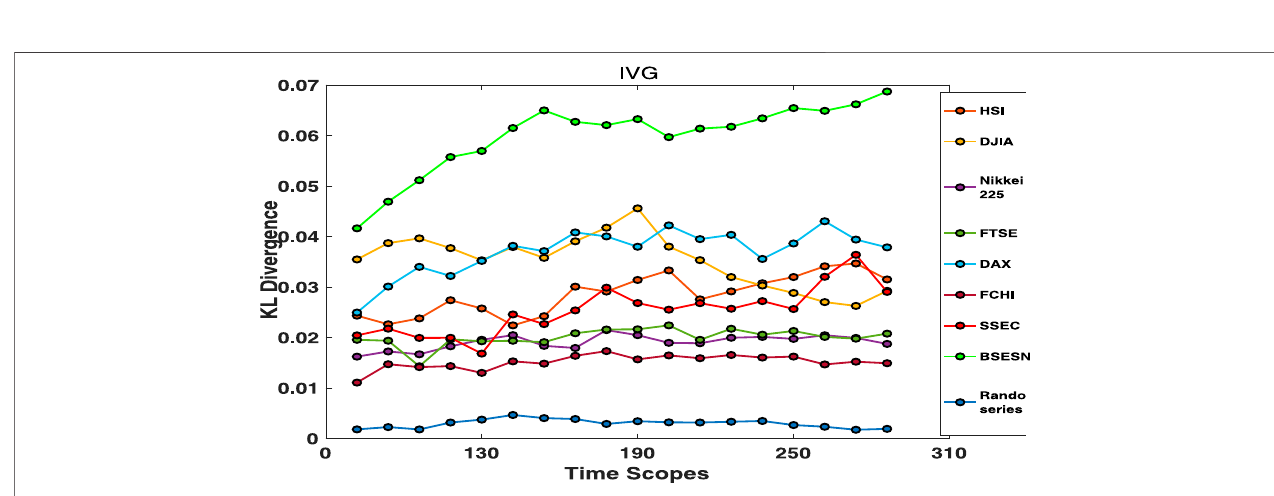
FIGURE 9 | KL divergences between I CV rise and fall distributions as functions of the time scope for eight stock indices and a pure random series.